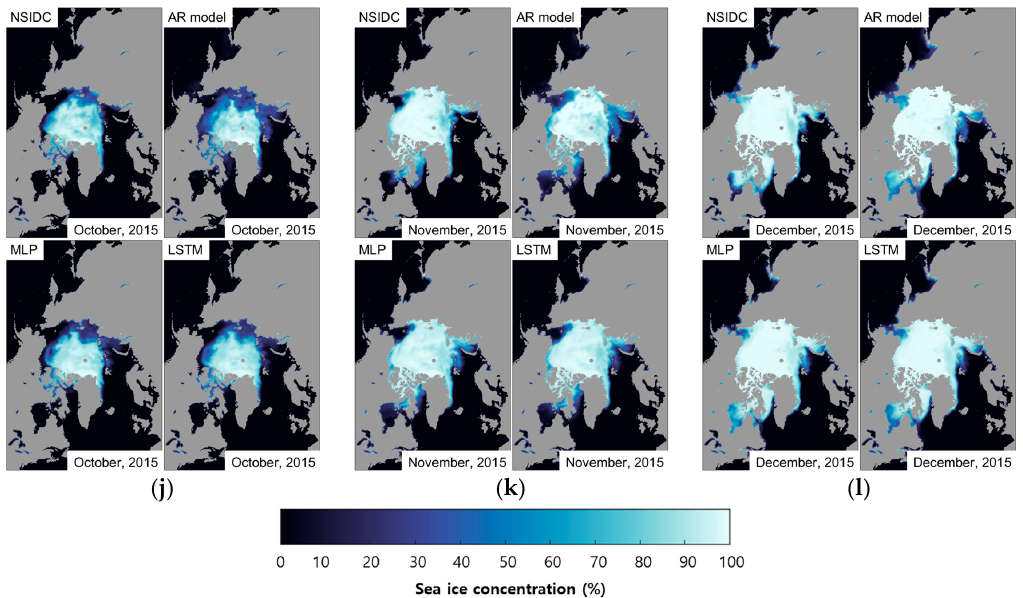
Figure 7. Monthly comparisons between the actual and three predicted SICs: ( a ) January; ( b ) February; ( c ) March; ( d ) April; ( e ) May; ( f ) June; ( g ) July; ( h ) August; ( i ) September; ( j ) October; ( k )